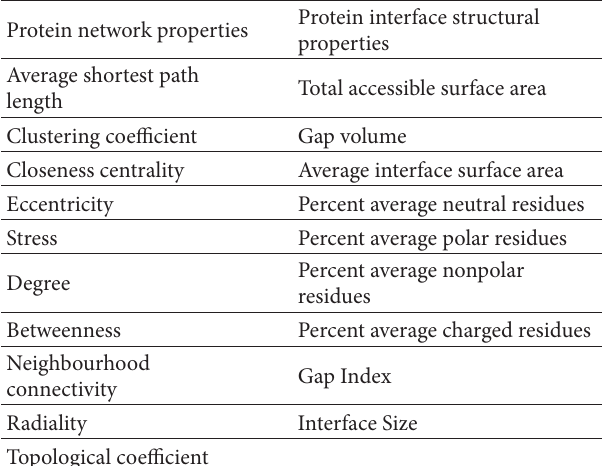
Table 1: Protein structural descriptors considered for machine